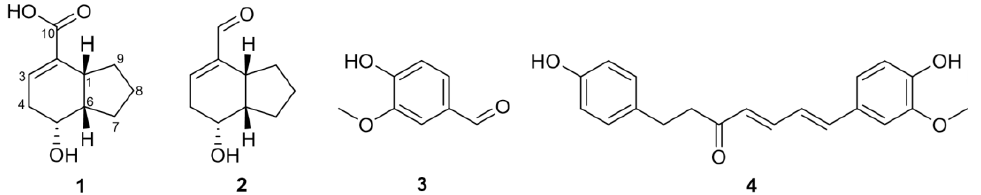
Figure 1. Chemical structures of isolates 1 – 4 from A. tsao-ko .